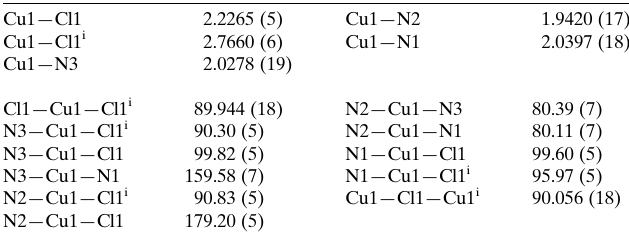
Table 1 Selected geometric parameters (A˚ , (cid:4) ).